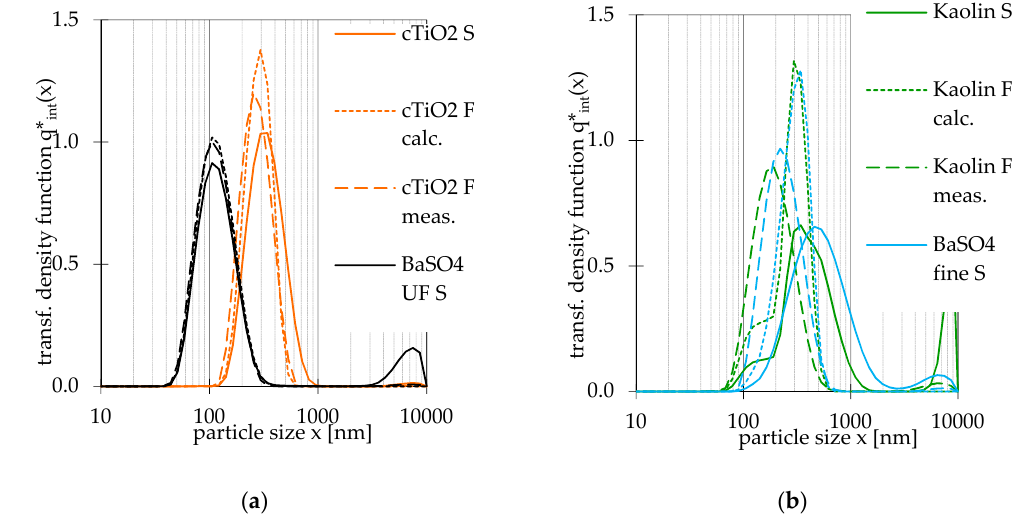
Figure 5. Comparison of intensity-weighted PSDs of feedstock (S) and 1.0 µm pore size filtrate (F): ( a ) Coated TiO 2 and BaSO 4 ultrafine (UF); ( b ) kaolin and BaSO 4 fine.